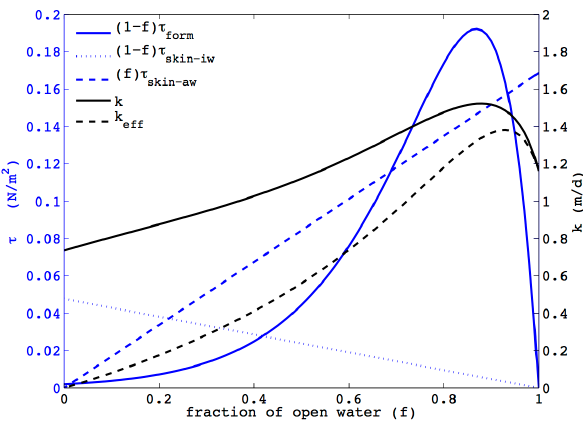
Fig. 3. A hypothetical example of the terms in the stress balance and gas transfer velocity ( k ) resulting from a constant RMS wind speed of 10 m s -1 and an ice drift velocity of 0.12 m s -1 at 75 ° N, 25 ° W. To parameterize the floe size, we used the scaling relationship of Toyota et al., (2006) to convert sea ice concentration (SIC) to a characteristic floe dimension (L).